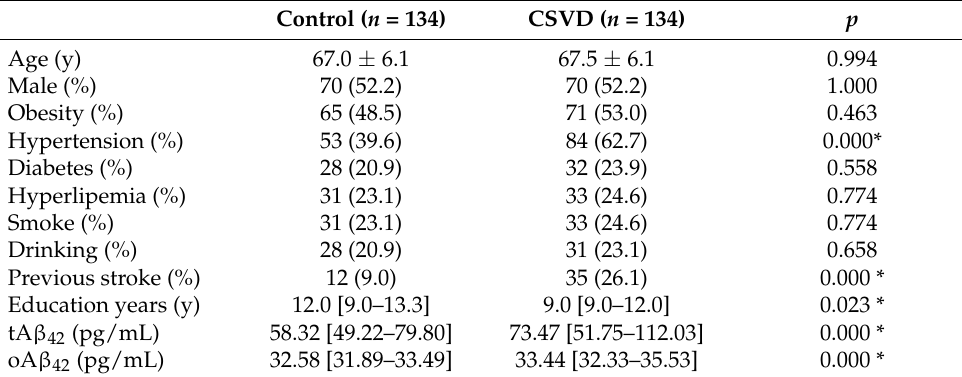
Table 2. Clinical characteristics and plasma A β 42 levels between groups.